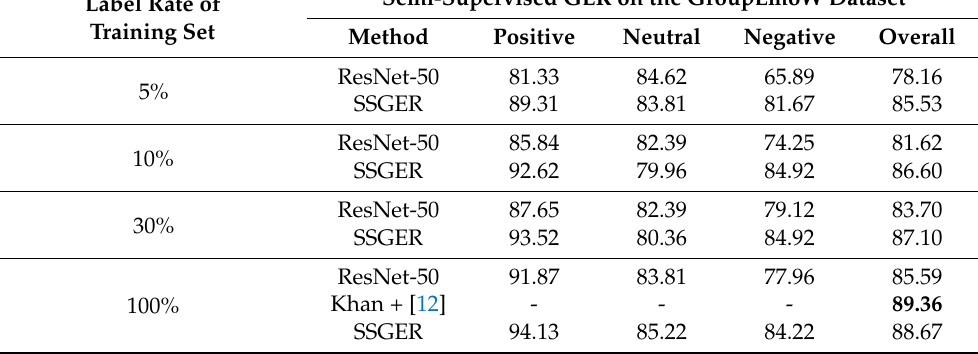
Table 4. Comparison of classification accuracy (in %) on the GroupEmoW dataset. The values in bold refer to the best result, and the symbol of “-” indicates the result was not reported in the paper of the compared